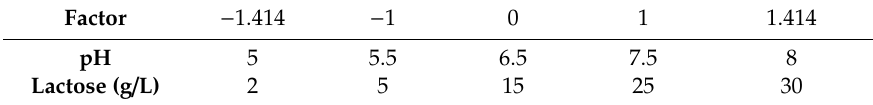
Table 3. Levels of independent factors used for central composite design.